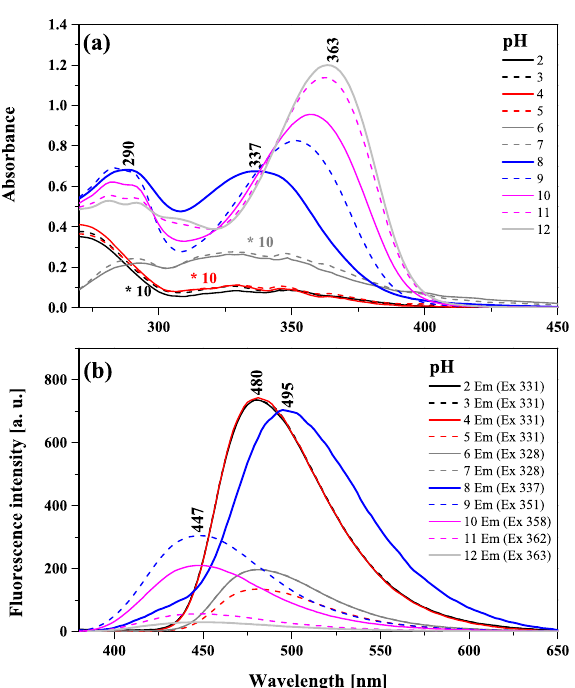
Figure 11. Absorption spectra for NTBD in water solution with varying pH (from 2 to 12) (panel a ) along with the corresponding fluorescence emission spectra (panel b ). The spectra were measured at room